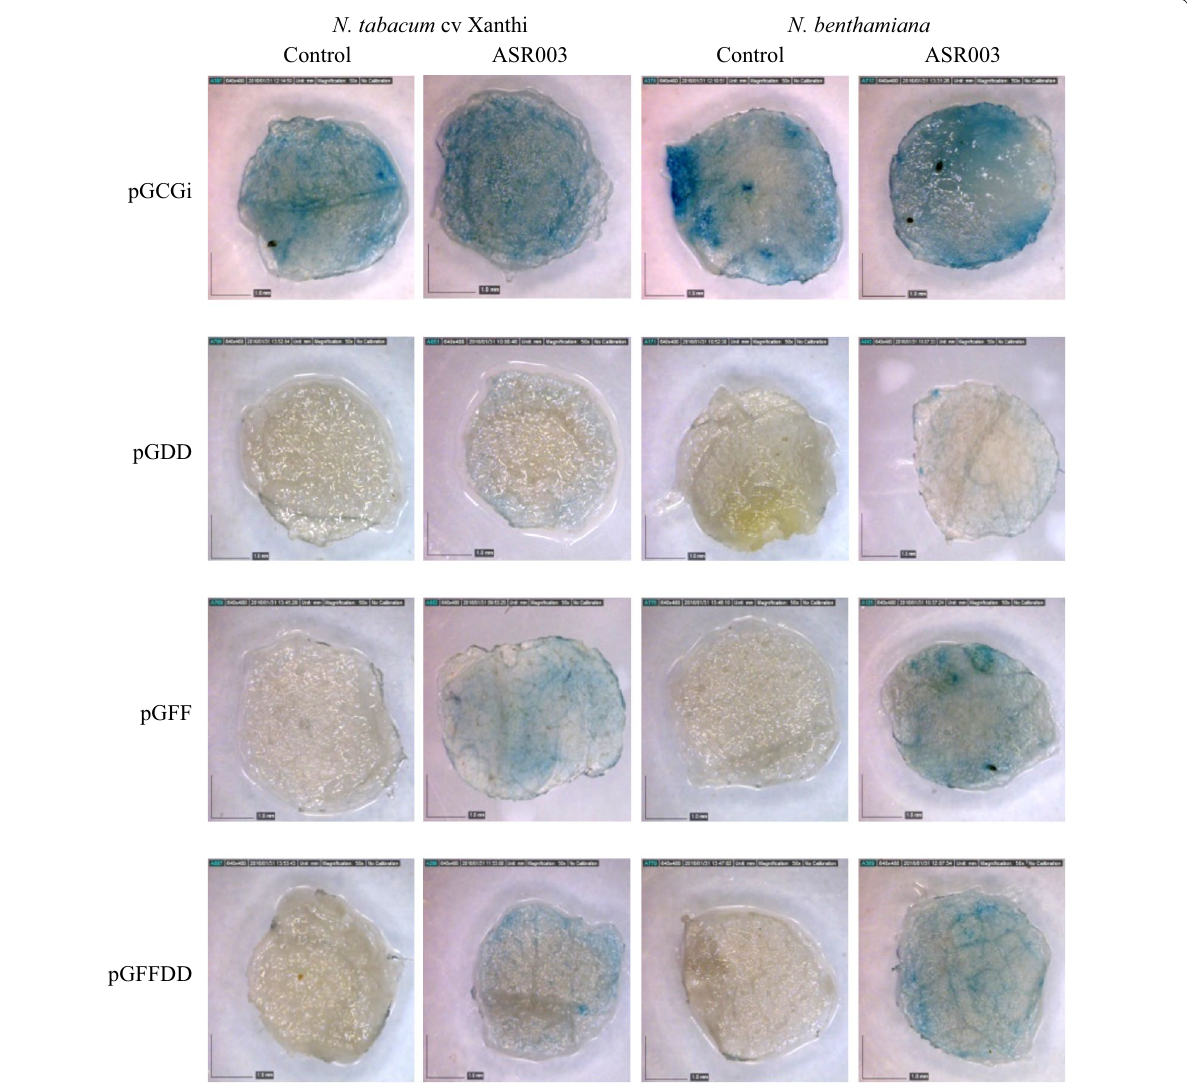
Fig. 7 Effect of Ascochyta rabiei pathotype ASR003 on pGCGi, pGDD, pGFF and pGFFDD constructs evaluated on two tobacco species; N. tabacum cv. Xanthi and N. benthamiana . Agro-injected plants without treatment by fungal elicitor used as control (More replications have been presented